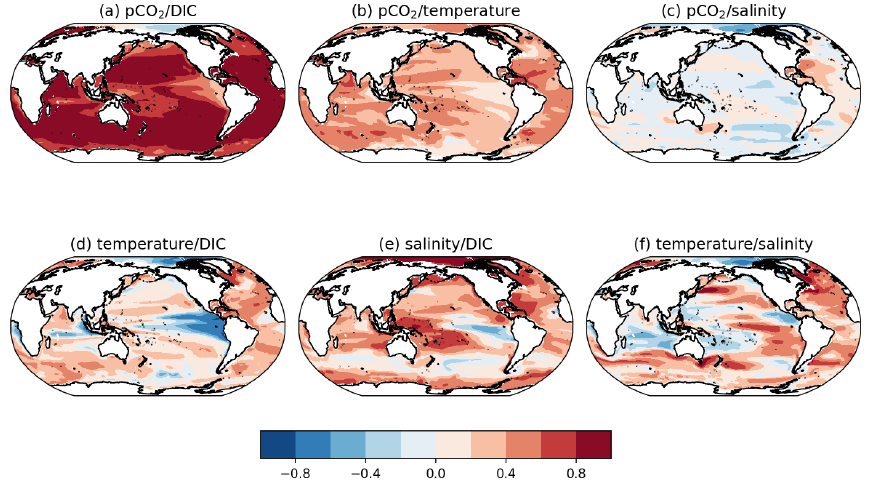
Figure 2. Correlations for the entire CMIP6 historical ensemble between changes in (a) atmospheric p CO 2 and upper-ocean (0–100m integrated) DIC, (b) atmospheric p CO 2 and upper-ocean temperature, (c) atmospheric p CO 2 and upper-ocean salinity, (d) upper-ocean temperature and DIC, (e) upper-ocean salinity and DIC, and (f) upper-ocean temperature and salinity.